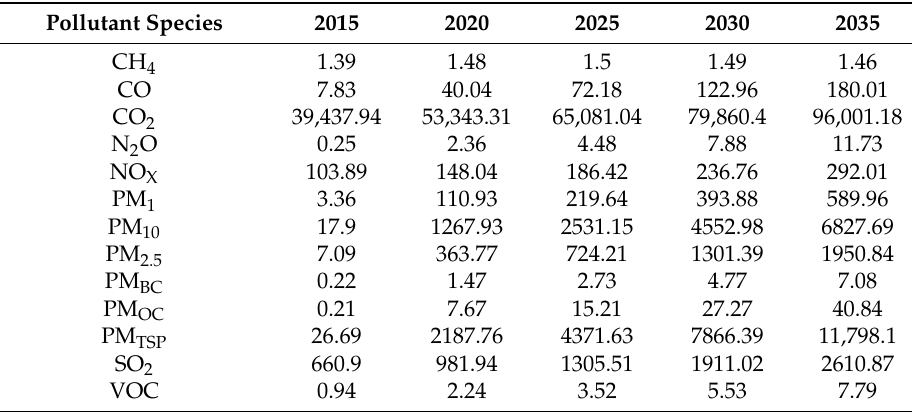
Table 6. Air pollutants emissions in the RE-40 scenario